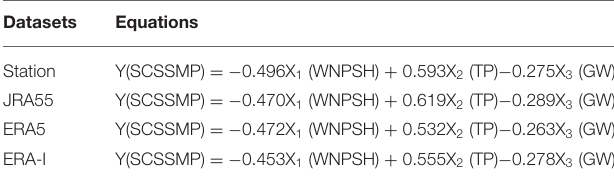
TABLE 3 | The final constructed multiple regression equations between the SCSSM precipitation and Tibetan Plateau summer surface temperature (TPST), WNPSH, global warming (GW) at four